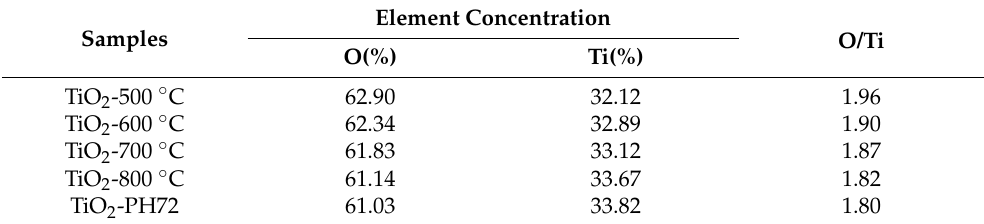
Figure 7. EDX images of the ( a ) TiO 2 -700 ◦ C and ( b ) TiO 2 -PH72 samples. Table 2. Element content and O/Ti of each sample from